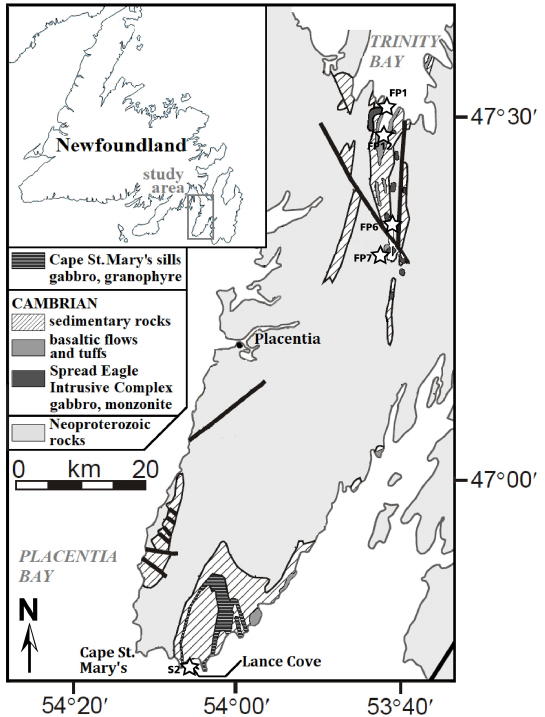
Figure 1. Simplified geological map of the western Avalon Penin- sula, compiled after King (1988) and O’Brien et al. (2001).